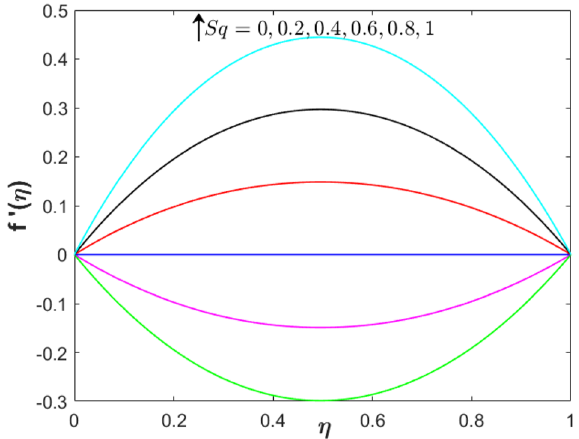
Figure 2. Effect of squeezing parameter on f ′ (η) when S = 0.2 , (cid:31) = 0 , M = 1 and φ 1 = φ 2 = 0.01 .